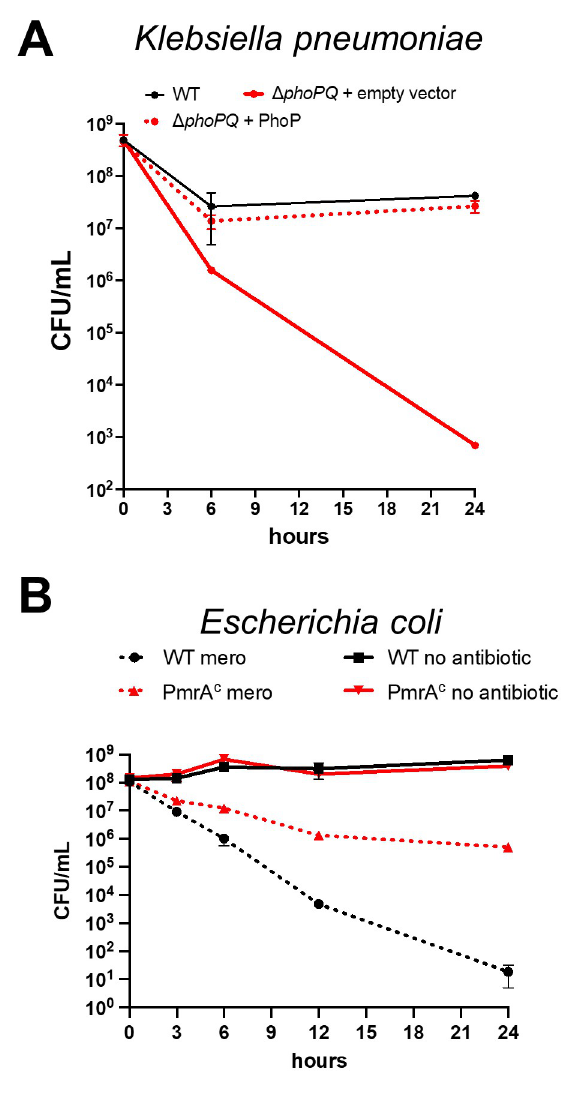
Fig 6. A conserved mechanism for meropenem tolerance in Enterobacterales. (A) Klebsiella pneumoniae 1084 carrying empty vector, and its Δ phoPQ derivative carrying either empty vector or pBAD33 phoP (“ Δ phoPQ + PhoP”) was diluted 10-fold into BHI medium containing 10 μ g/mL meropenem (100 x MIC) and 0.2% arabinose for induction. Data represent averages of 3 replicates +/- standard deviation (B) E . coli strain W3110 (WT) or strain WD101, which has a constitutively active chromosomal copy of pmrA ( pmrA C ), were cultured in N-minimal medium and treated with or without meropenem. Cultures were incubated statically at 37˚C. CFU were enumerated at indicated time points. Error bars indicate standard deviation. Each experiment was independently replicated three times in triplicate, and one representative data set was